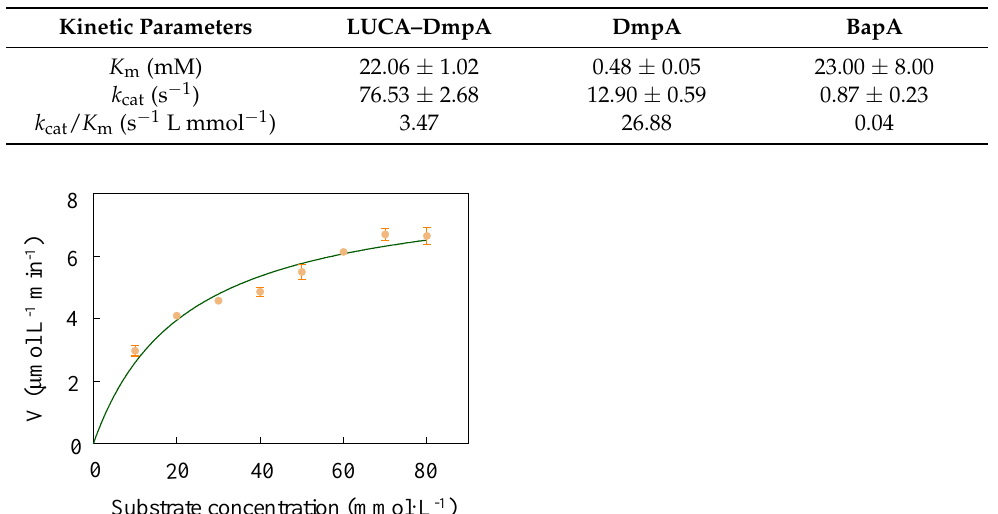
Table 1. The kinetic parameters of LUCA–DmpA, reported BapA and DmpA. Initial rates of L-carnosine formation catalyzed by LUCA–DmpA were analyzed from 100 mM L-His and eight